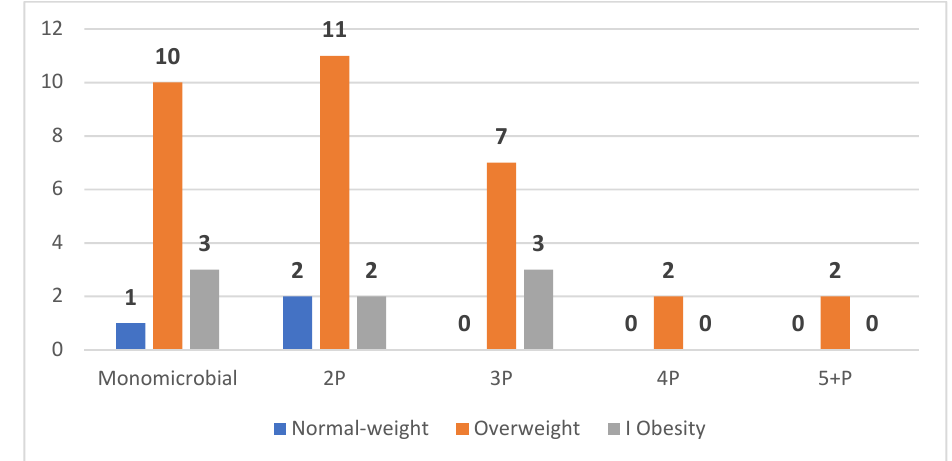
Figure 3. Monomicrobial and polymicrobial infections and DFU patient lifestyle: BMI. P2: polymi ‐ crobial infection colonized by 2 microorganisms; P3: polymicrobial infection colonized by 3 micro ‐ organisms; P4: polymicrobial infection colonized by 4 microorganisms; P5+: polymicrobial infection colonized by 5 or more microorganisms.